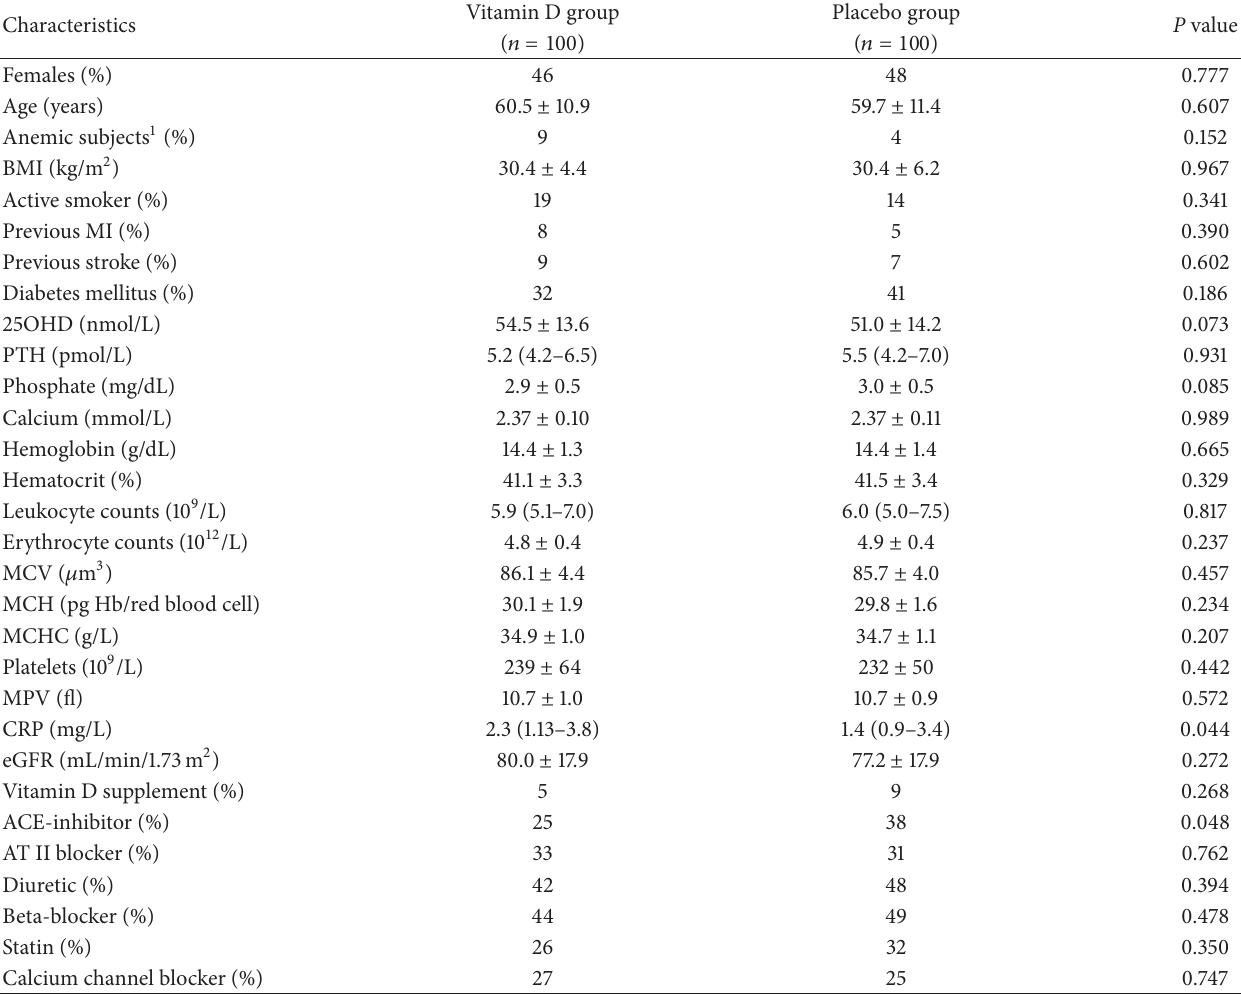
Table 1: Baseline characteristics of the study